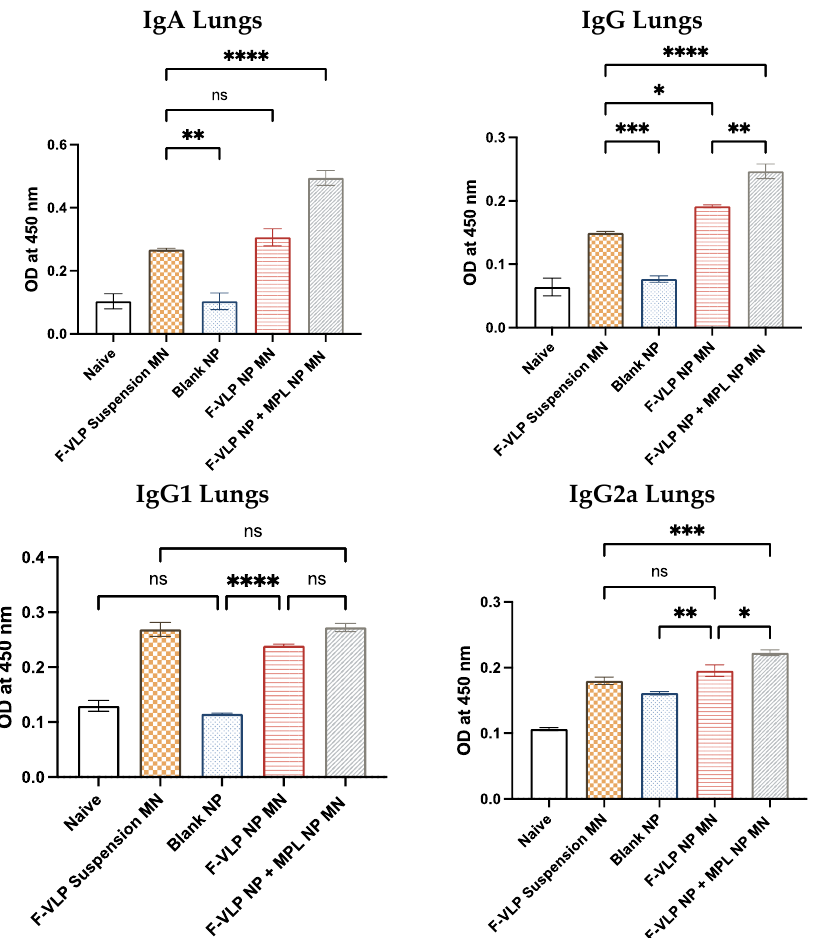
Figure 5. F-protein-specific antibody response in the lung homogenates of immunized mice post- RSV challenge. Antibodies specific to the RSV F-protein were analyzed using the RSV F-protein as the ELISA-coating antigen. ( Top ) F-protein-specific IgG and IgA in the lung homogenates. ( Bottom ) F-protein-specific IgG subtypes IgG2a and IgG1 in the lung homogenates. * p < 0.05, ** p < 0.01,*** p < 0.001 and **** p < 0.0001, ns: not